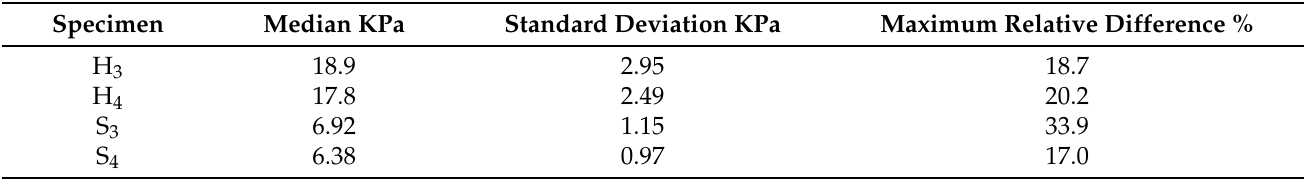
Table 2. Combined results of all mechanical methods and the statistical